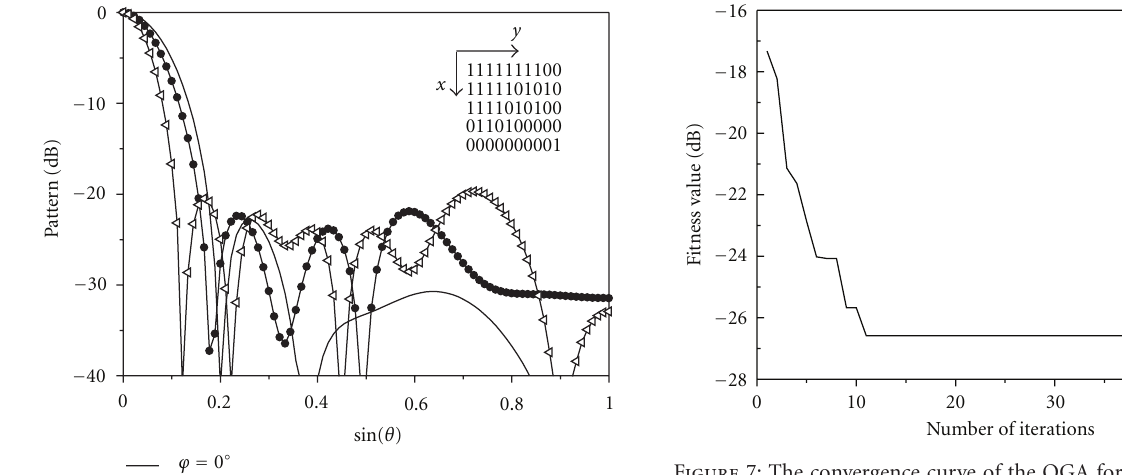
Figure 7: The convergence curve of the OGA for the planar array with the fitness function as (8).